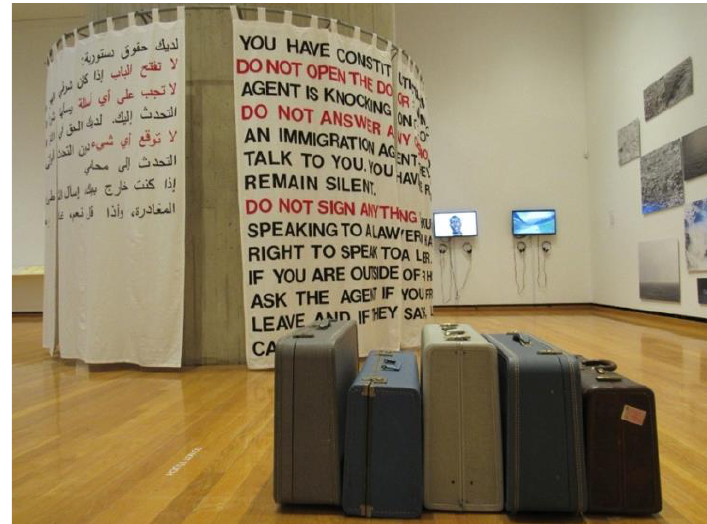
Figure 5 Aram Han Sifuentes, Messages to My Neighbors (2016 – ongoing). Fabric, felt, and fusible web (left); Peng! Collective, Fluchthelfer.in Become an Escape Agent (2015). Two single-channel videos (back center); Dawit L. Petros, Historical Rupture (detail) from the series The Stranger’s Notebook (2016 – 17). Archival color pigment prints (back right); and Zoe Leonard, Untitled (2001), five suitcases